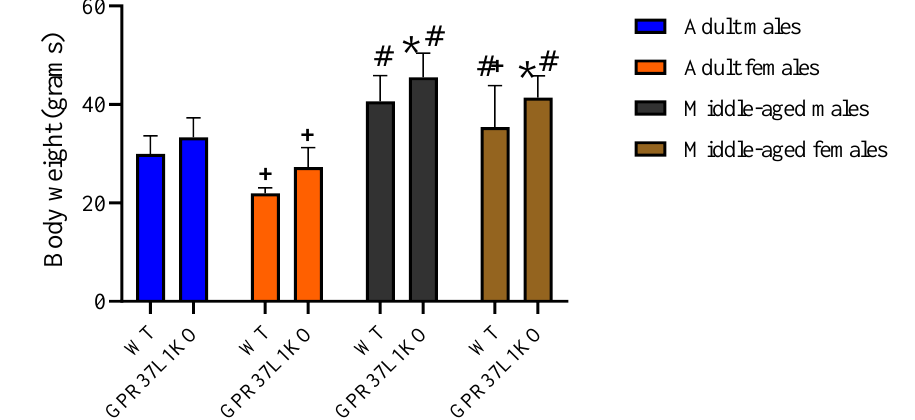
Figure 7. Effect on the level of body weight in adult and middle-aged WT and GPR37L1KO males and females. n /group: 8 to 12. All data represent mean ± SD. * p < 0.05 within genotype; # p < 0.05 versus corresponding age; + p < 0.05 with respect to sex calculated by three-way ANOVA, followed by multiple comparisons using the two-stage linear step-up procedure of Benjamini, Krieger and Yekutieli. WT = Wild Type,